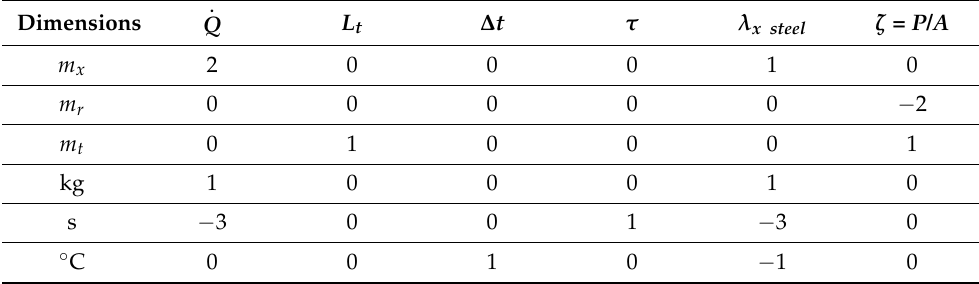
Table 7. Matrix A, comprising independent variables.